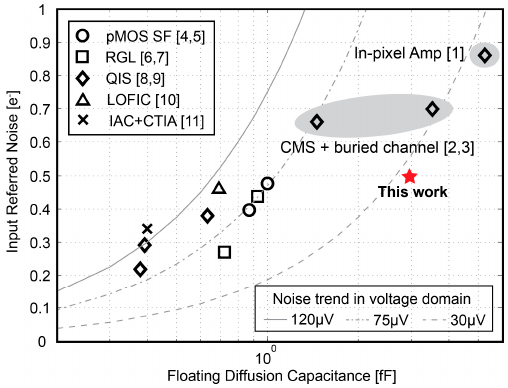
Figure 13. Comparison of input-referred noise in the electron domain vs. FD capacitance, and noise trend in the voltage domain with reported image sensors. The values are based on the best guess with the known values of CG FD in reported publications [13].